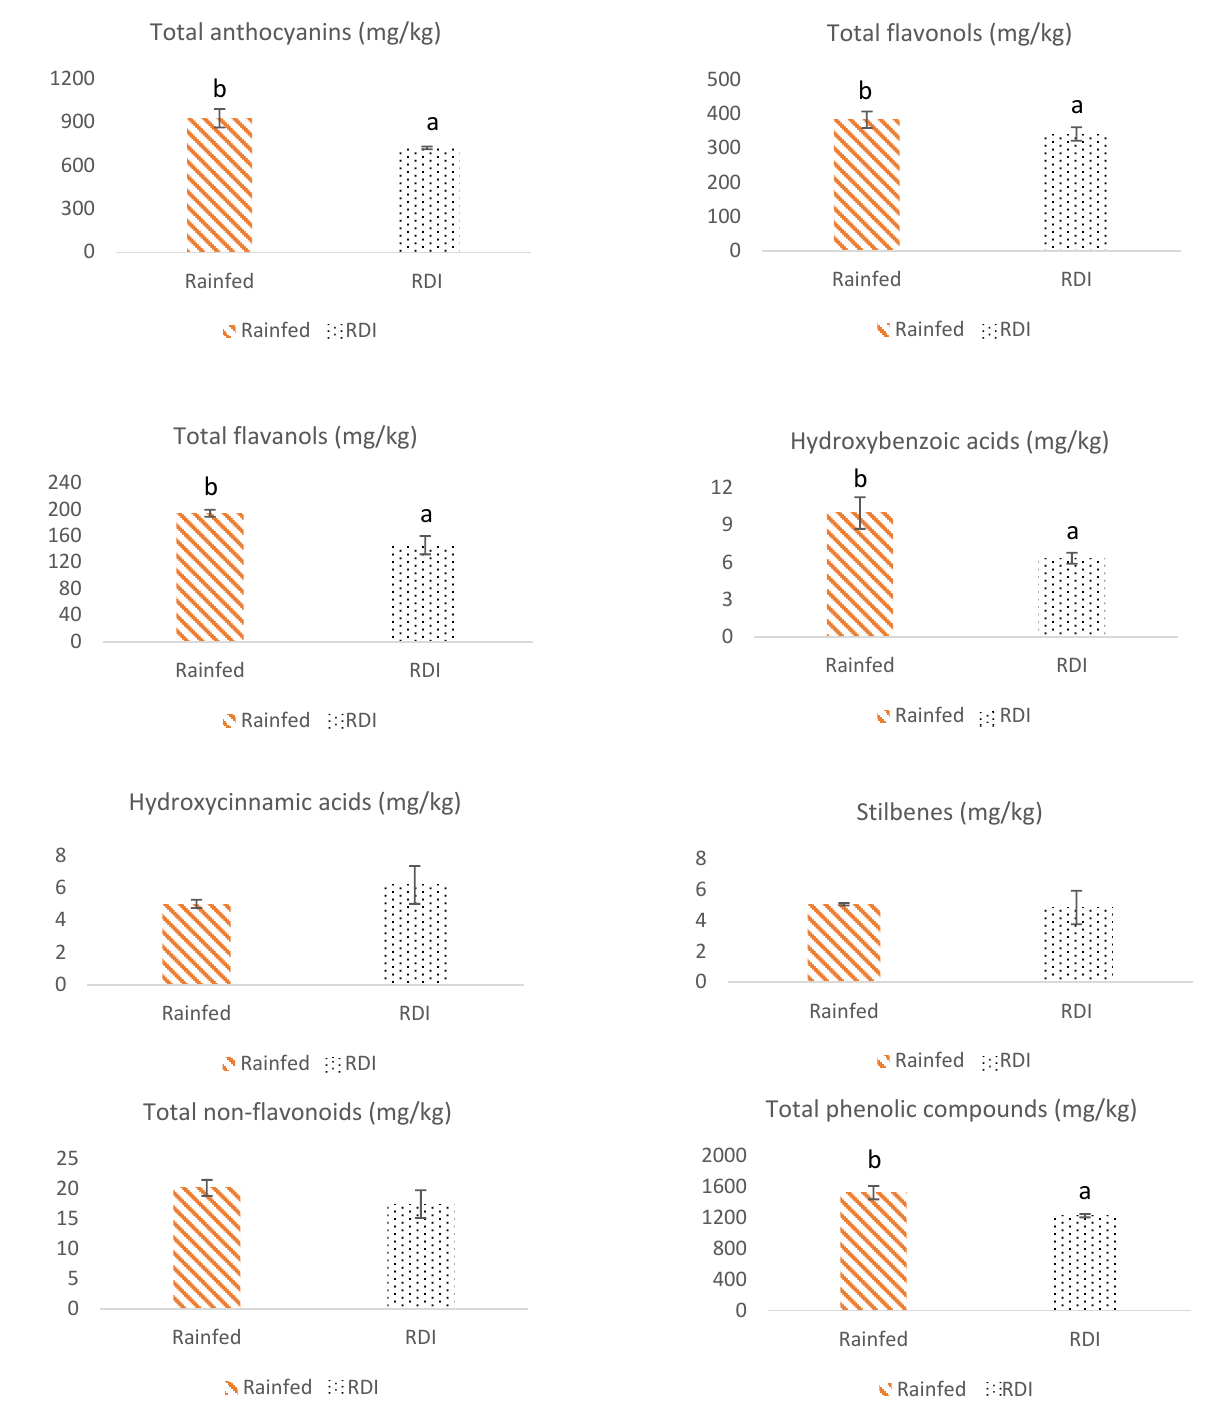
Figure 1. Mean values of total phenolic compounds and total content (mg/kg) of different groups of phenolic compounds in Monastrell grapes. Bars represent the standard deviations ( n = 4). Different letters (a and b) indicate significant differences between grapes under non-irrigation (rainfed) and regulated deficit irrigation (RDI) regimes ( p ≤ 0.05). When there is no difference between treatments ( p > 0.05), no significance letters are shown.